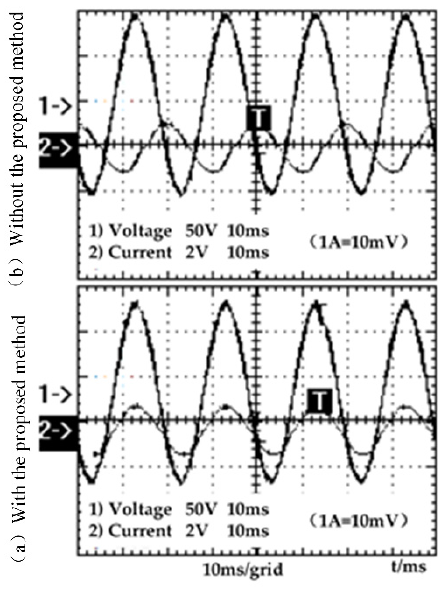
Figure 9. SVG Waveforms of U–I relation before and after compensation (resistive–inductive load).